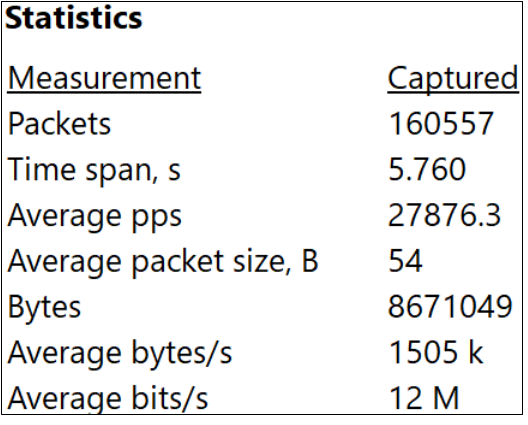
Figure 6. Source-destination-wise packet statistics .